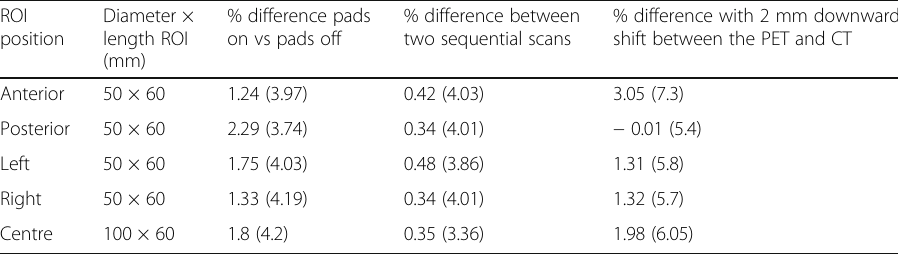
corrected using the MaxProb method (which does not account for hair) and PET im-